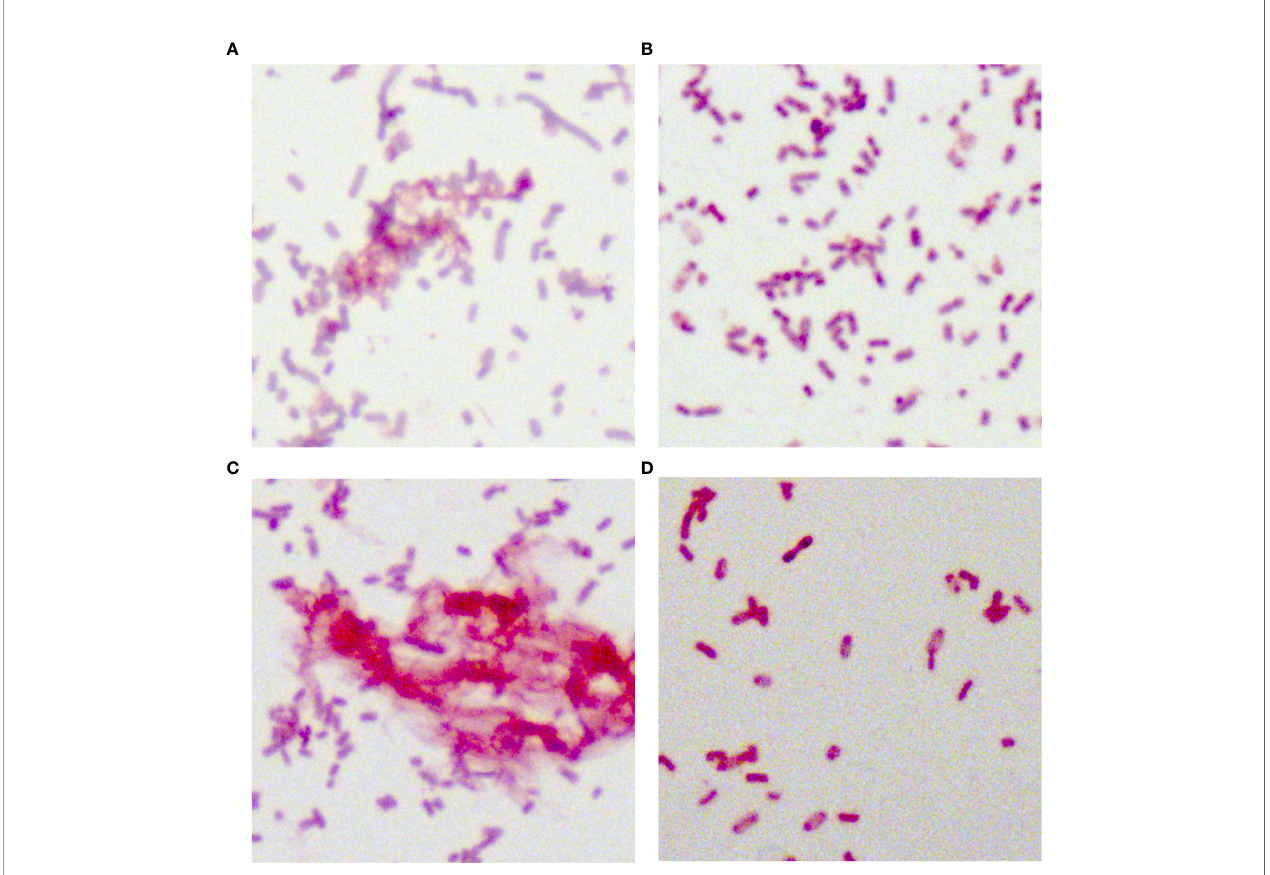
FIGURE 5 | Periodic acid-Schiff staining of 35 putative bla KPC (+)-HvKP and Hv- bla KPC (+)-KP strains. (A) Klebsiella pneumoniae NTUH-K2044, (B) K. pneumoniae HS11286, (C) JS184, and (D) TZ20. K. pneumoniae strains were purple/red and rod-shaped; the red fl uffy masses were exopolysaccharides. bla KPC , beta- lactamase K. pneumoniae carbapenemase gene; bla KPC (+)-HvKP, bla KPC (+) hypervirulent K. pneumoniae ; Hv- bla KPC (+)-KP, hypervirulent bla KPC (+) K. pneumoniae.